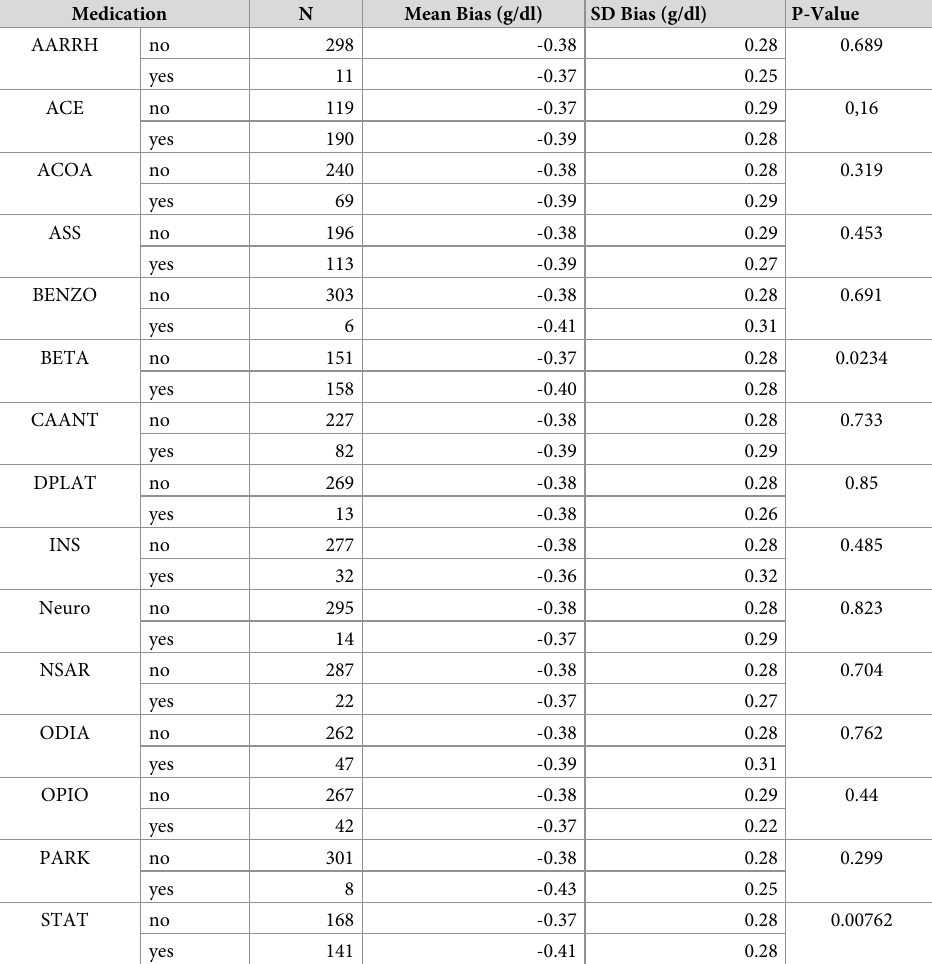
Table 2. Biases depending on co-medication (LIB-07 and LIB-26).